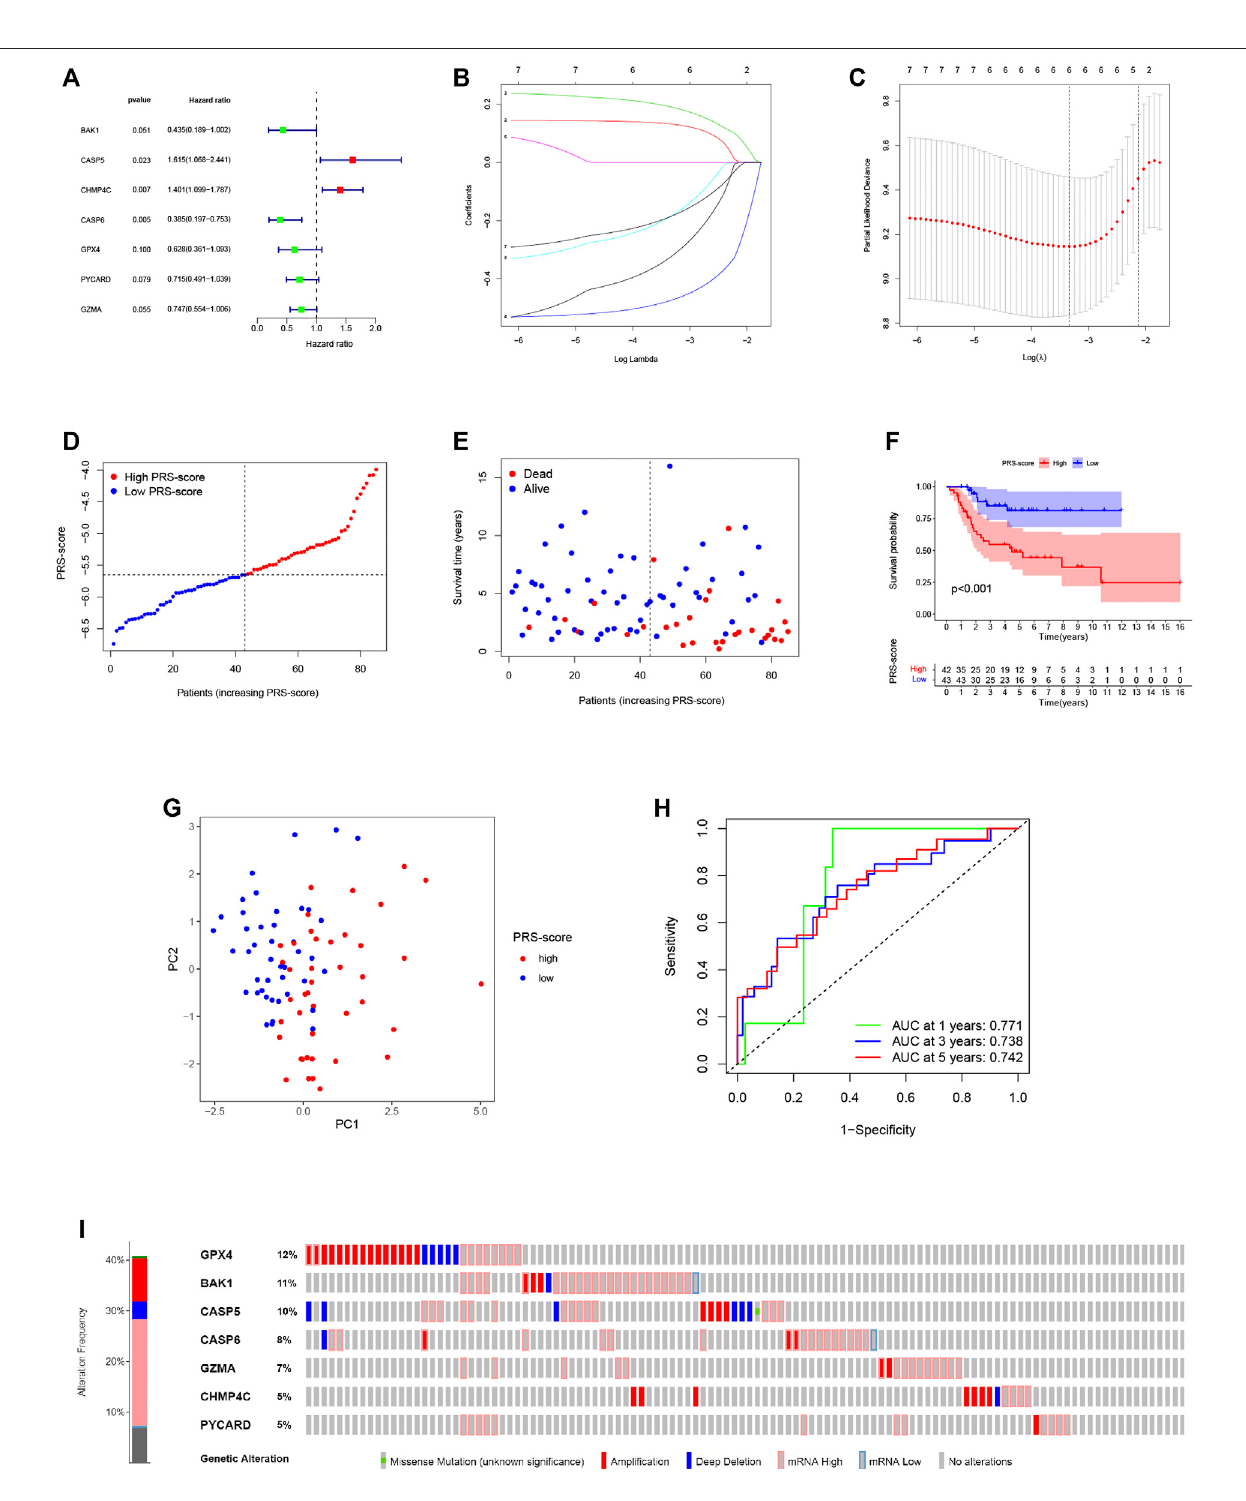
FIGURE 4 | Construction of the pyroptosis-related prognostic signature for osteosarcoma. (A,B) Cox regression analysis of pyroptosis-related genes. (A) Univariate Cox regression analysis. (B) LASSO Cox regression analysis. (C) Selection of the optimal penalty parameter for LASSO regression. (D) The PRS-score distribution of the patients with osteosarcoma in the TARGET cohort (E) The survival status and survival time distribution of the patients with osteosarcoma in the TARGETcohort. (F) Kaplan – MeiercurvesofthehighandlowPRS-scoresubgroupsintheTARGETcohort. (G) PCAplotbasedonthePRS-scoresintheTARGET cohort. (H) Time-dependent ROC curve for predicting the 1-, 3-, and 5-year overall survival in the TARGET cohort. (I) Genomic alterations of hub genes.